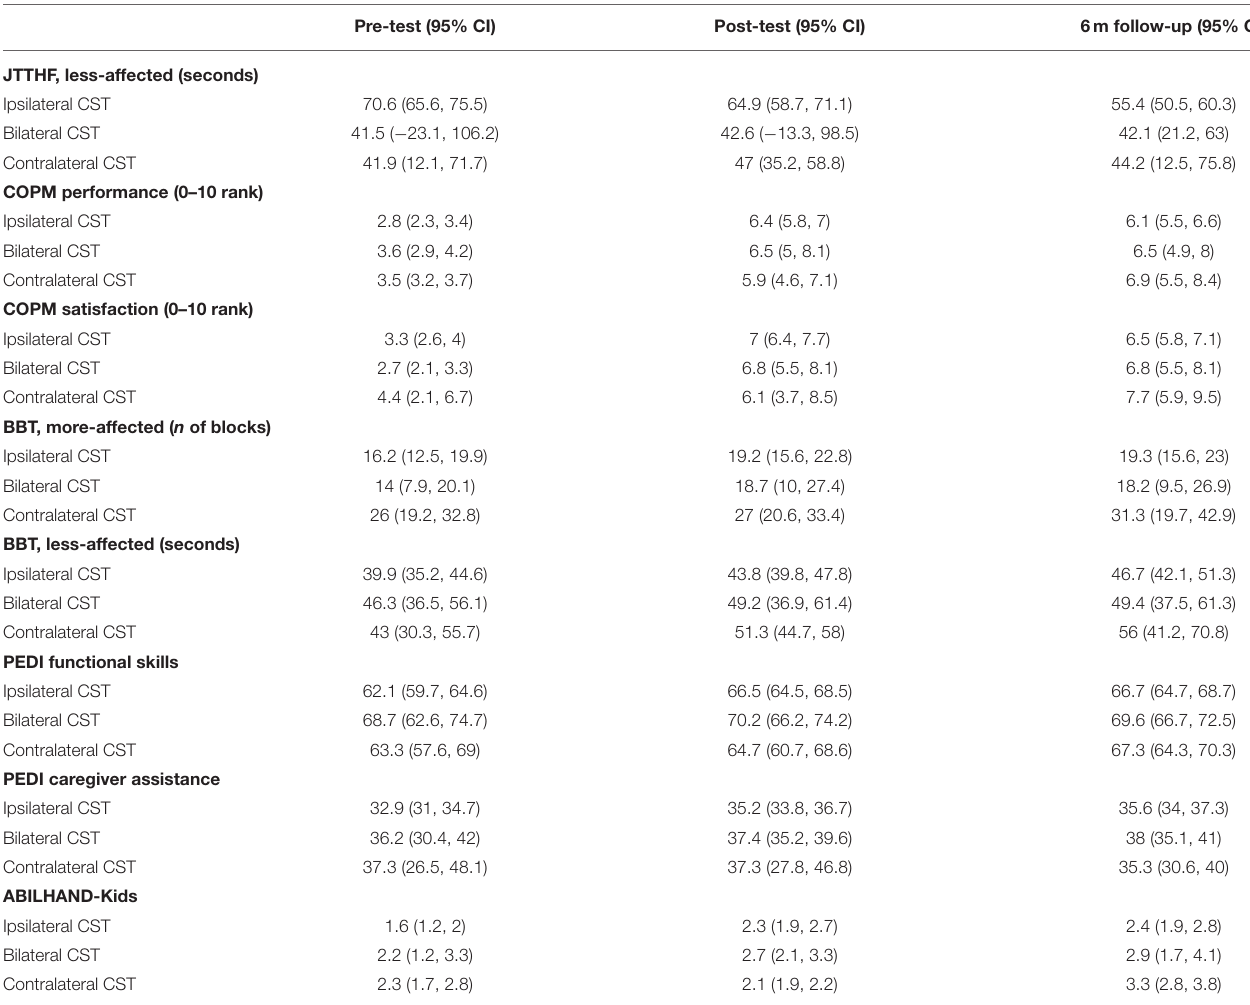
Frontiers in Neurology |